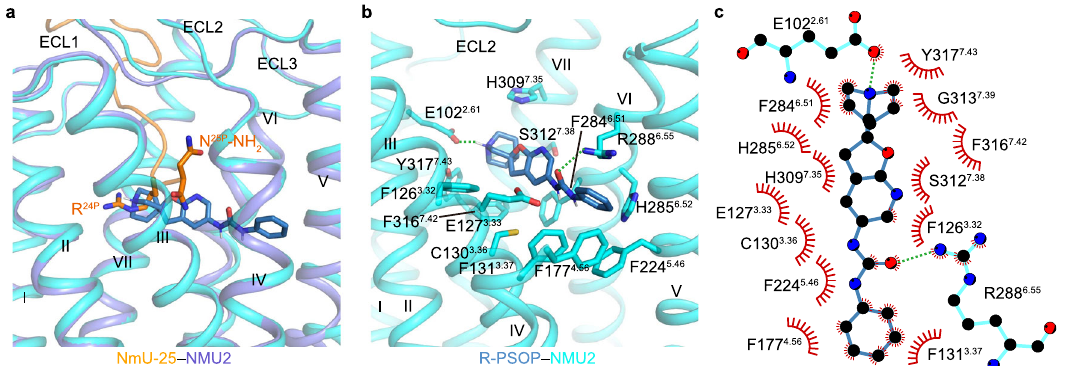
Fig. 3 | Molecular docking of R-PSOP in NMU2. a Docking pose of R-PSOP in NMU2. Receptors of the NmU-25 – NMU2 complex and R-PSOP – NMU2 docking modelare shown asslate and cyan cartoons. Ligandsare shown asorange and sky- blue sticks. b Close view of the interactions between R-PSOP and NMU2. The